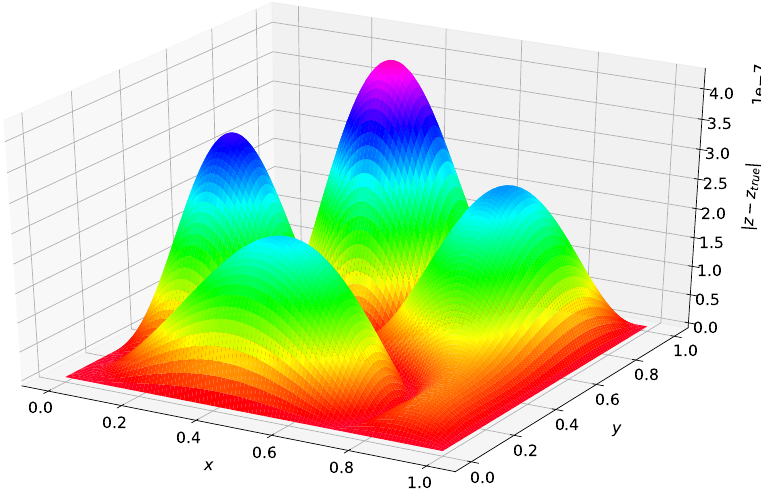
Figure 3. Problem 1 solution error using Ref. [5] solution form.